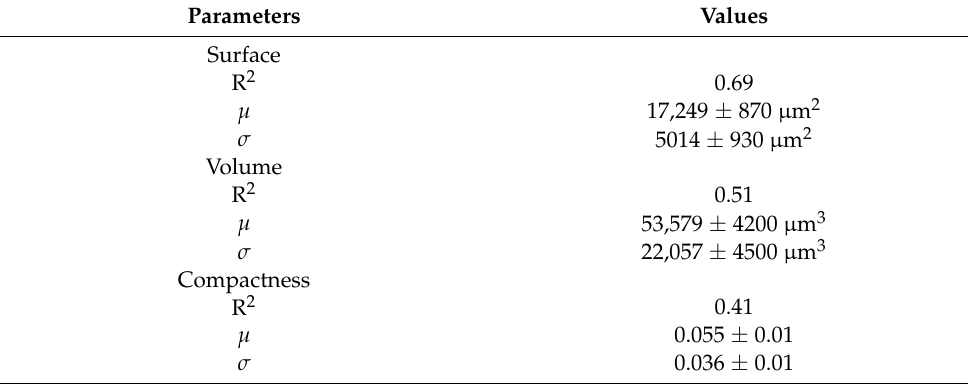
Table 1. Surface area, volume and compactness. Values were obtained by a Gaussian non-linear regression of frequency distribution of data from six mouse left kidneys (see Figure 4b,d,f). Estimated mean ( µ ) and standard deviation ( σ ) of the Gaussian distribution (see Equation (5)) of each parameter are expressed as mean ±